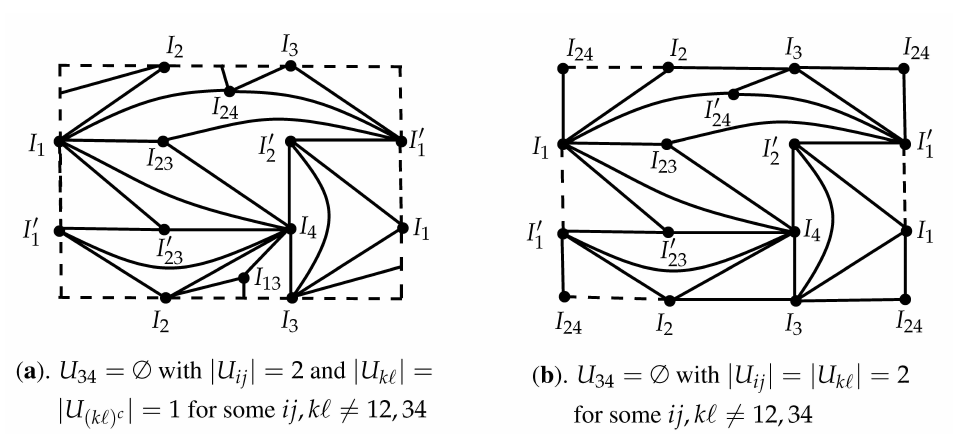
∪ 4 U n | = 6 with | U 1 | = | U 2 | = 2. n = 1